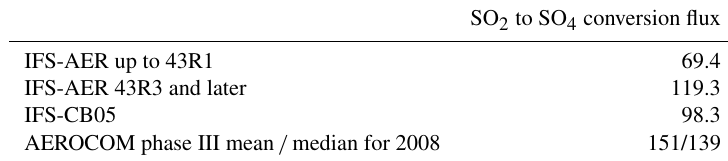
Table 6. Global conversion of sulfur dioxide into particulate sulfate in 2014 (TgSO 4 yr − 1